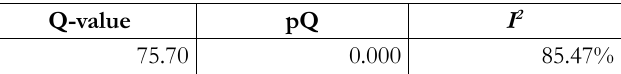
Table 7. Test of